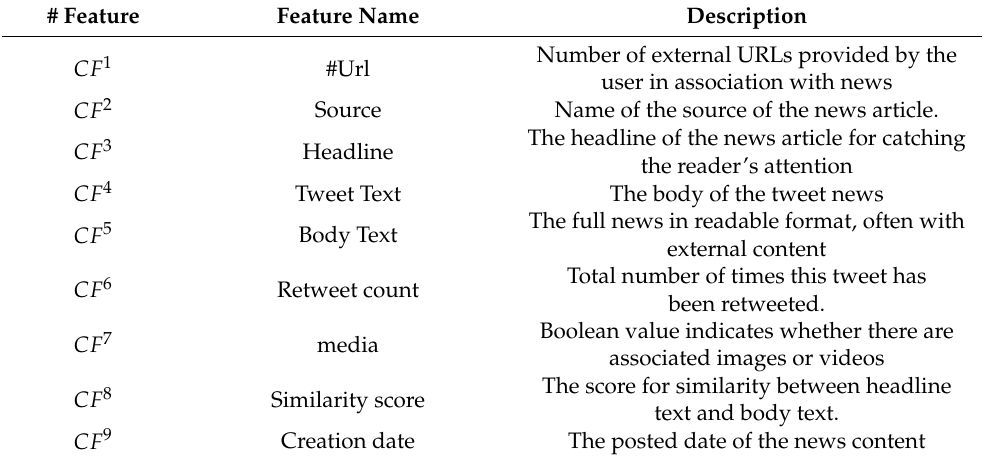
Table 3. Content-based